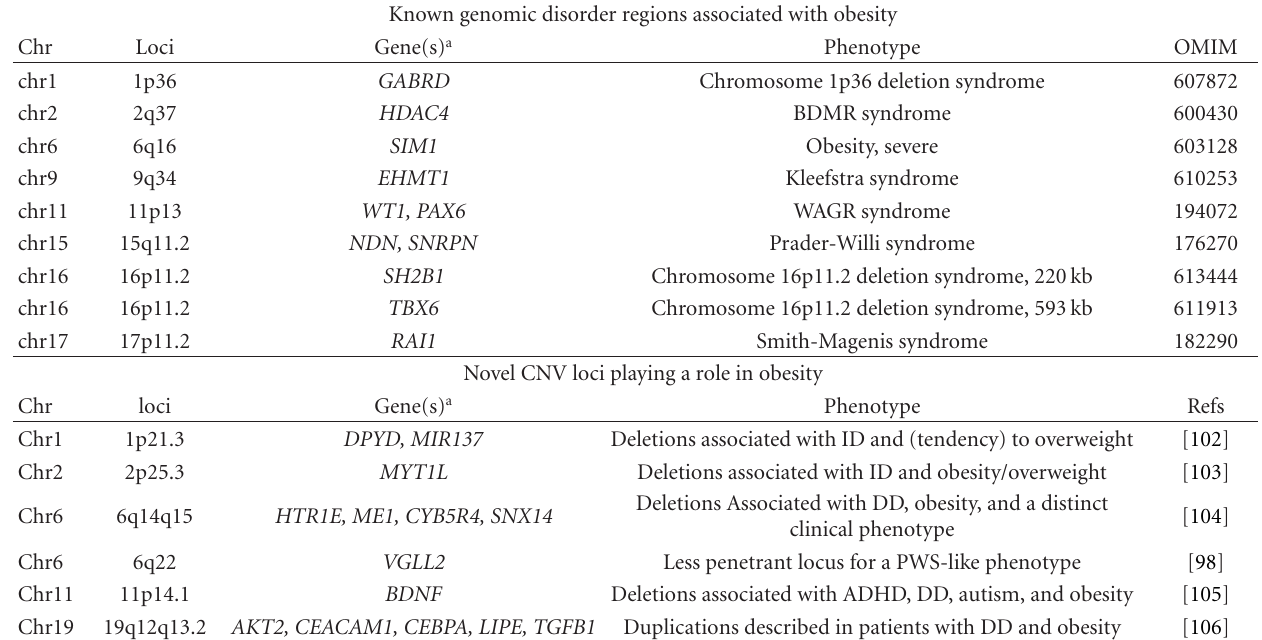
Table 1: Genomic regions encompassing genes involved in the development of obesity and developmental delay/intellectual